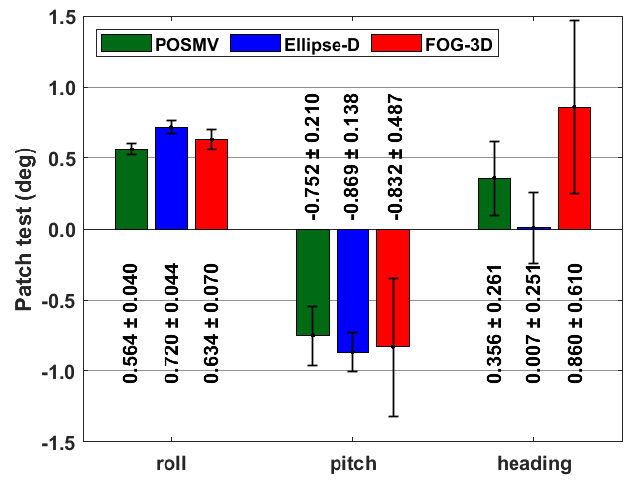
Figure 8. Roll, pitch, and heading calibration offsets and their respective 1-sigma uncertainties.